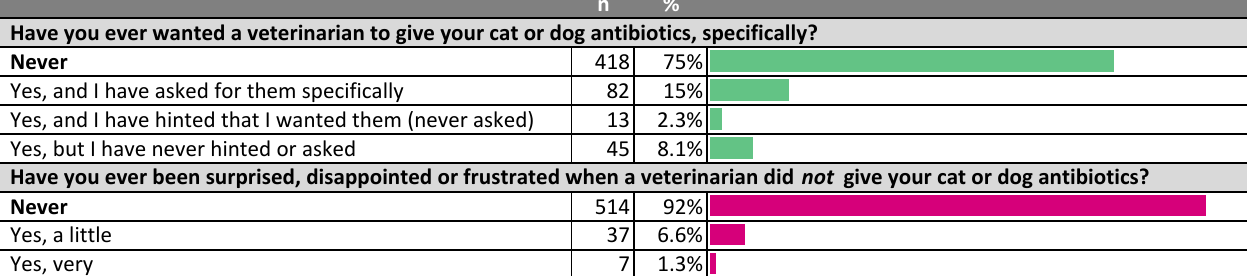
Figure 5. Owner desire, hints and requests for antibiotics for their pets.